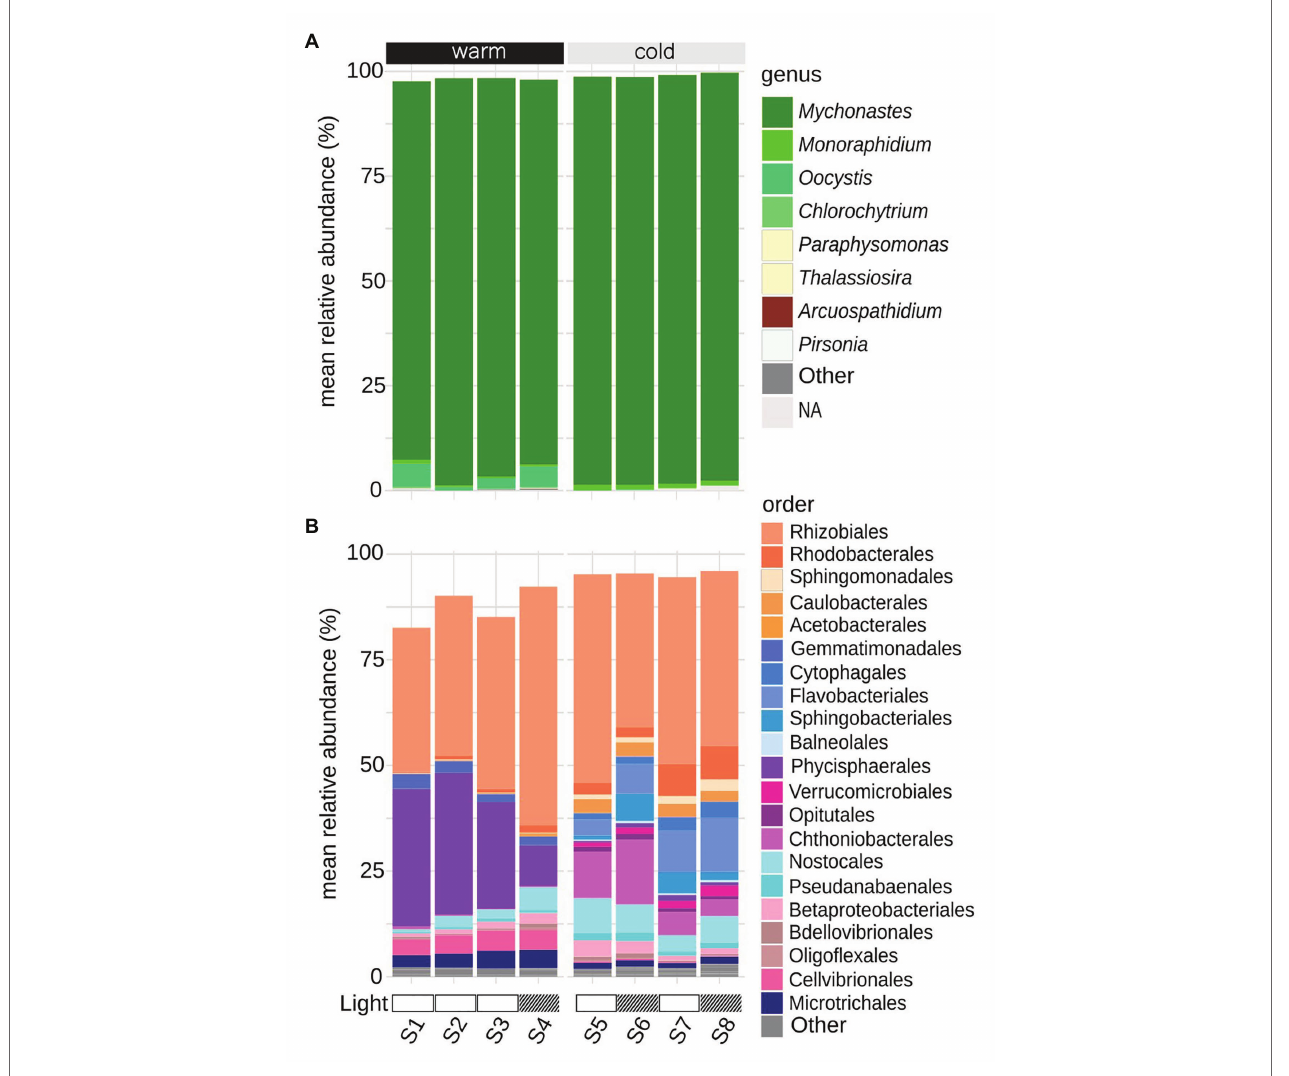
FIGURE 3 | Taxonomic affiliation of ASVs, mean of triplicates per sampling date (S1–S8), with a relative abundance > 0.1%. (A) 18S ASVs with assigned taxonomy at the genus level. (B) 16S ASVs with assigned taxonomy at the order level. Warm: 19.5 ± 0.89 ° C, cold: 12.4 ± 1.76 ° C (mean temperature per 24 h in PBR); Light: light reduction, open bar → natural light, striped bar → light reduced by 40–60% by